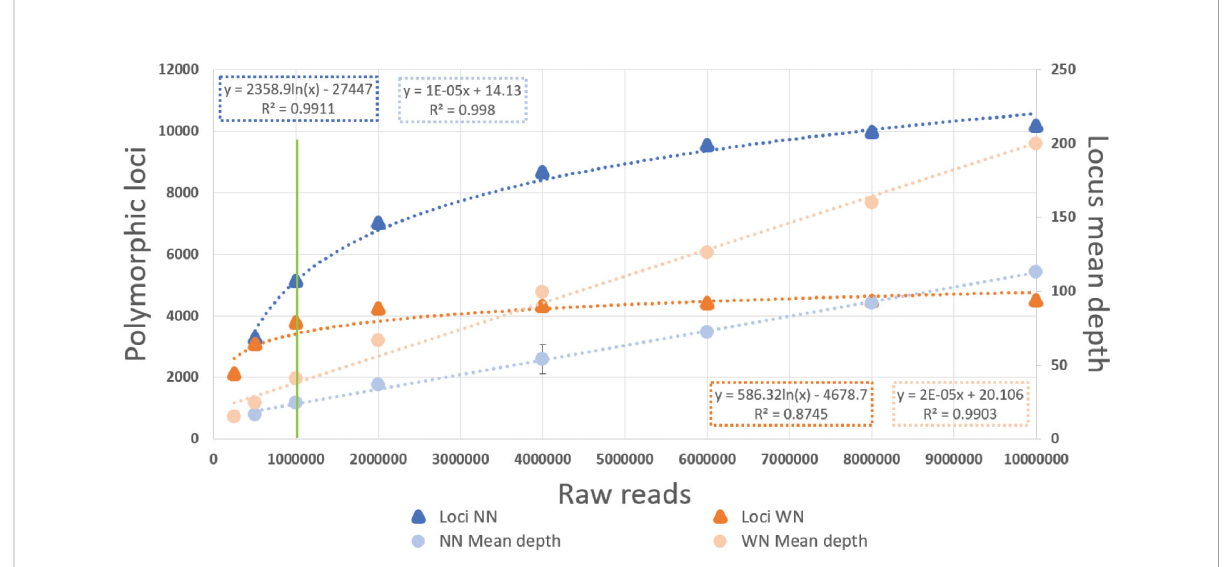
FIGURE 5 Results of the resampling analysis. Mean number of polymorphic loci and mean depth per locus at different initial raw number of reads simulated by resampling analyses (N=10 iterations) for the NN and WN 75% fi ltered fi les. Error bars represent the standard deviation of the 10 replicates for each simulated dataset with 250K, 500K, 1M, 2M, 4M, 6M, 8M and 10M raw reads. The green line indicates the mean number of raw reads empirically obtained in the present study. The formulas in the dark colored boxes correspond to the number of polymorphic loci regression and the formulas in the light colored boxes correspond to locus mean depth, for the NN (blue) and WN (orange) simulated